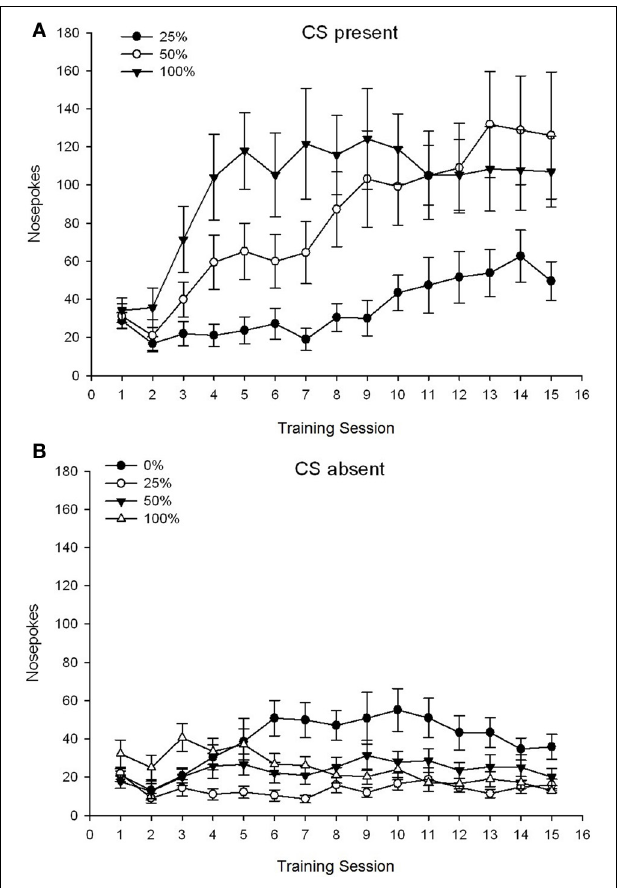
FIGURE 1 | Mean (SE) approach responses (nose pokes) on 15 sucrose training sessions in groups of Sprague Dawley rats ( n = 8/group) exposed to sucrose reward (10% solution) delivered under 0, 25, 50, or 100% variable schedules. The conditioned stimulus was a light (120s). Group 0 received the same number of rewards as group 100 in the absence of conditioned stimuli. (A) Scores when CS was present (5s × 15 trials). (B) Scores when CS was absent (average for 5 × 15s while light was